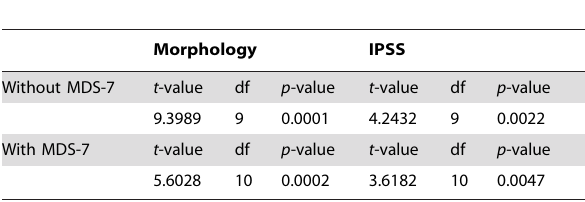
Table 5. Two group t -test results for the discrimination of MDS grade of using General Variant Level score in the sense of cell morphology and